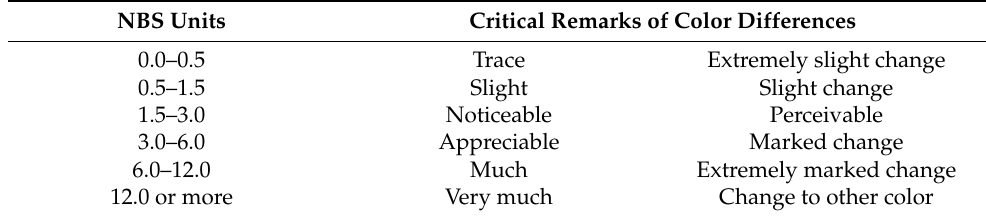
Table 2. Criteria of the National Bureau of Standards (NBS) units